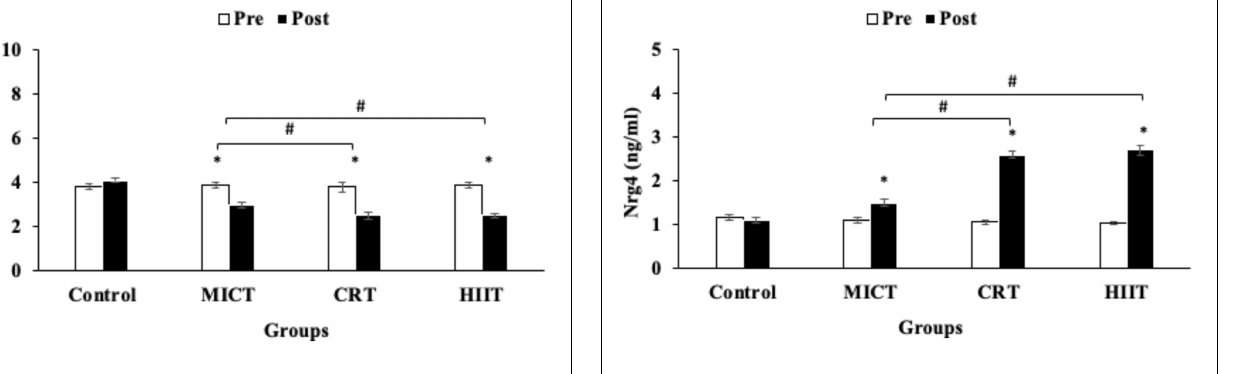
( p > 0.05) with TG ( r = − 0.212), VLDL ( r = − 0.195) and insulin